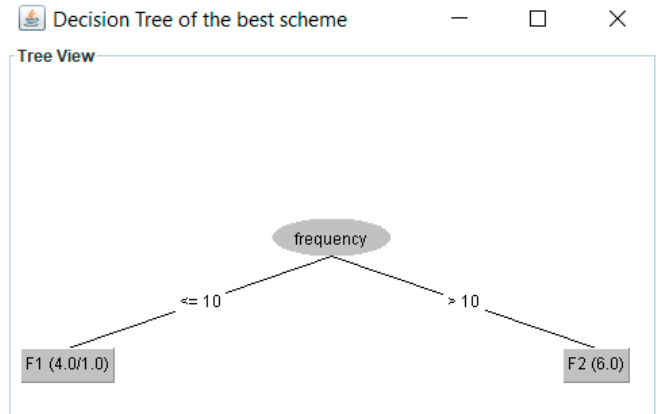
Figure 7. Decision tree for 2 fragments found by FTree for the first experiment. Other classification algorithms were used to select the fragmentation scheme. Table 12